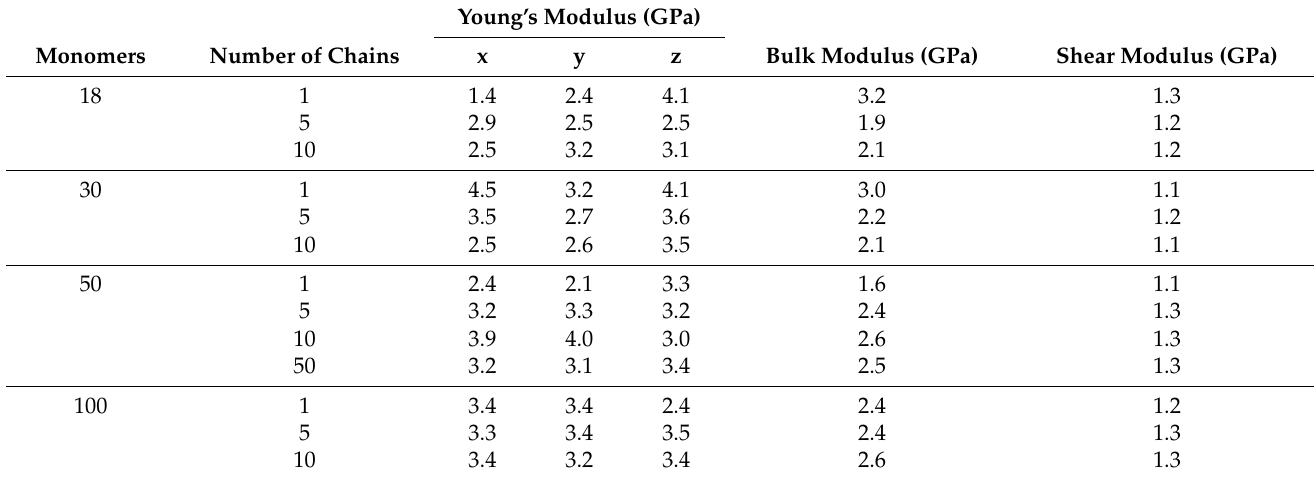
Table 1. Mechanical properties for amorphous polypropylene unit cells with 18 to 100 monomers and 1 to 50 PP